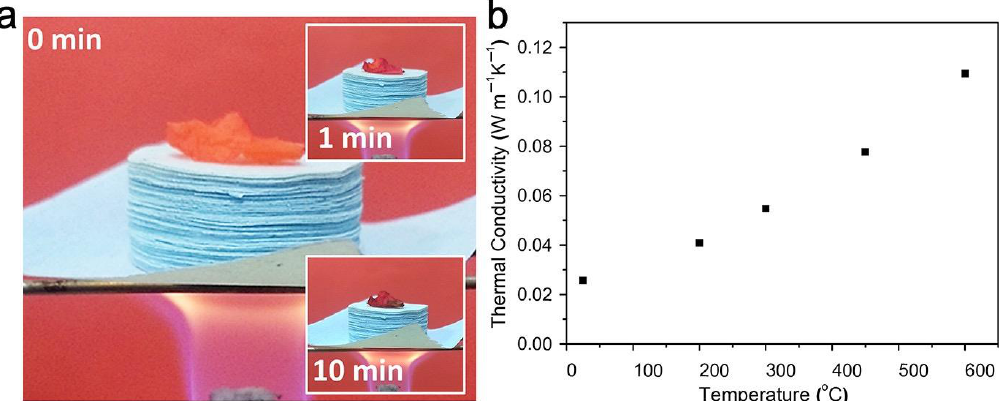
Figure 13. Thermal insulation performance of the SiC NWA. ( a ) Fresh petal protected by a piece of aerogel with a thickness of 10 mm from withering or carbonization under the heating of an alcohol lamp for 10 min. ( b ) Thermal conductivity of the SiC NWA in N 2 at different temperatures (Reprinted with permission from Ref. [11]. 2018 American Chemical Society).